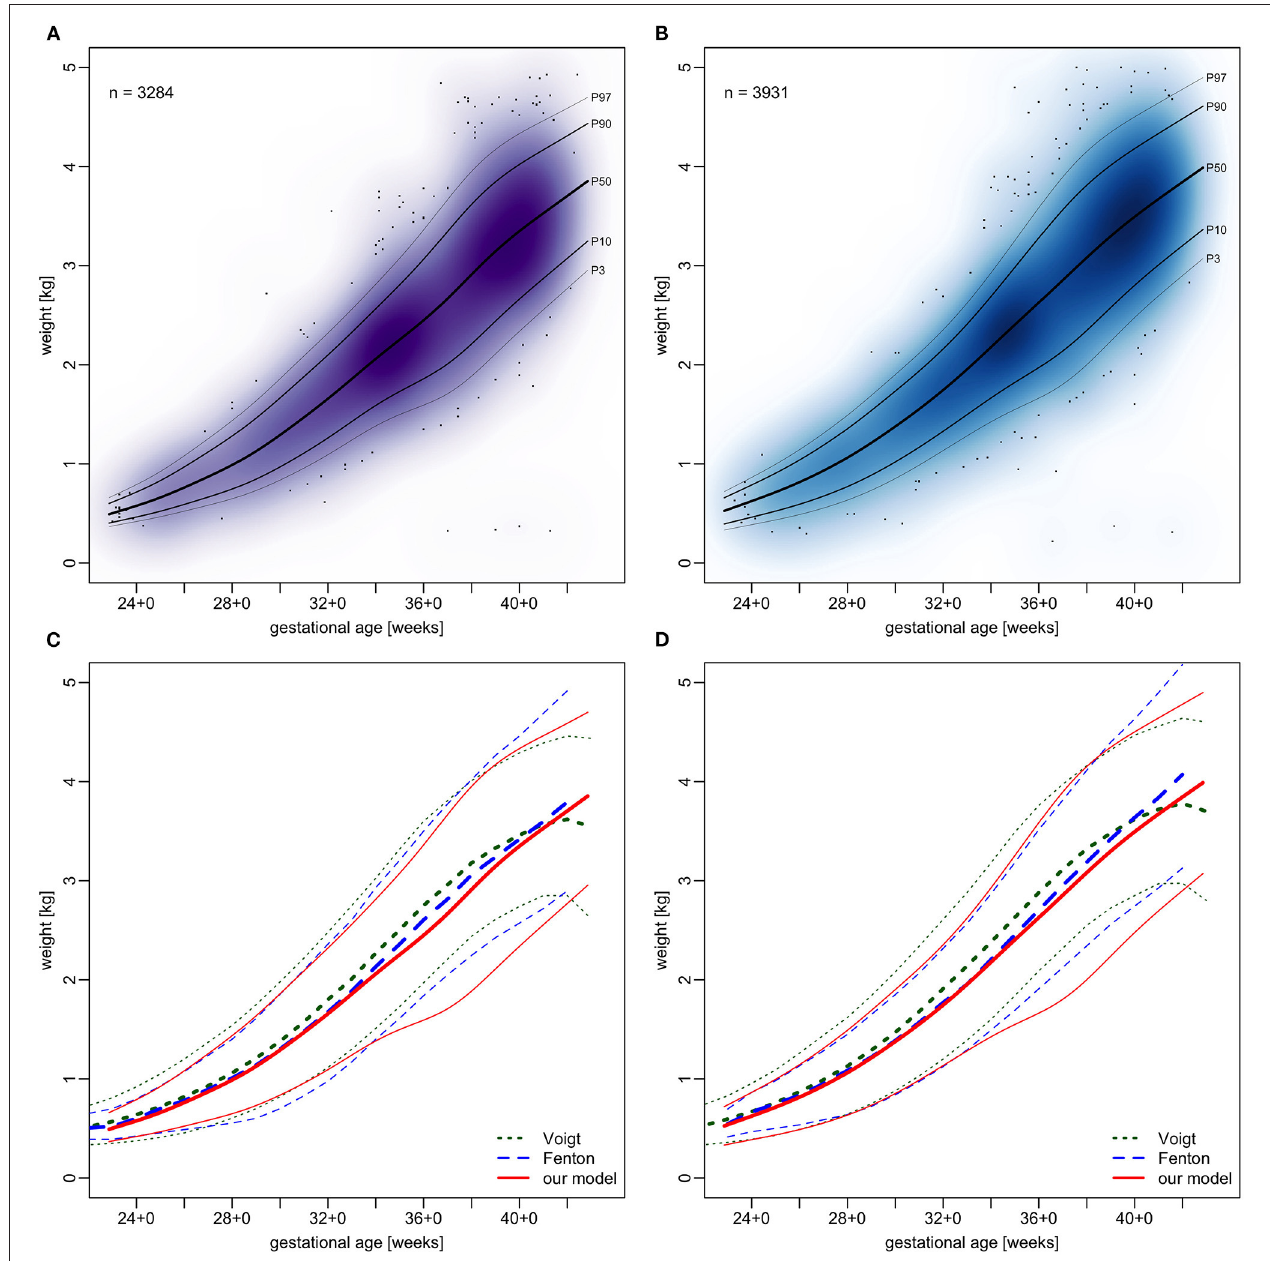
FIGURE 7 | Charts of weight in relation to gestational age. (A,B) our sample with fitted models. (C,D) comparison of our models (red) with Voigt et al. (17) (green) and Fenton and Kim (13) (blue), shown are 3rd, 50th, and 97th percentiles. (A,C) girls and (B,D)